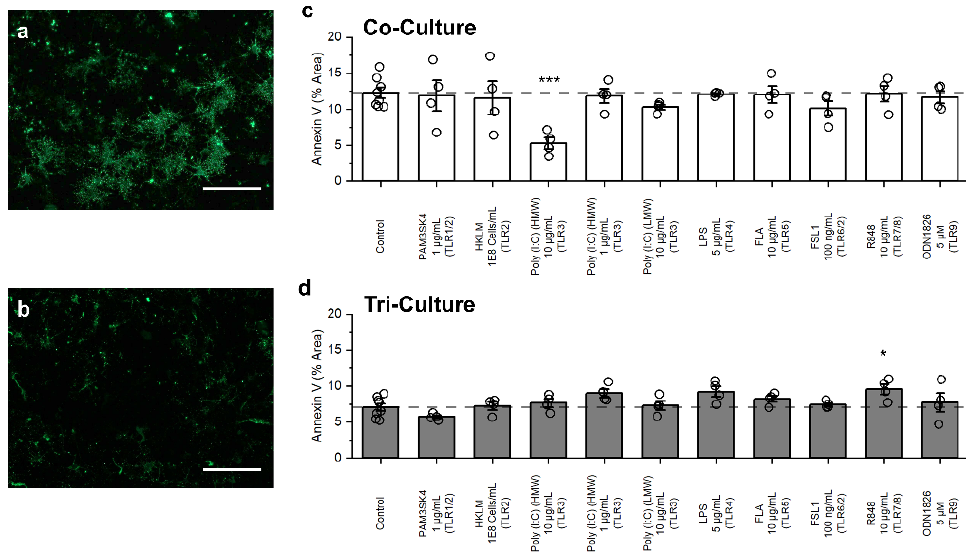
Figure 3. Influence of TLR agonist treatment on Annexin V staining. Representative fluorescence images of the ( a ) co-culture and ( b ) tri-culture at DIV 9. Quantification of the Annexin V staining in the ( c ) co-cultures and ( d ) tri-cultures following 48 h exposure to TLR agonists. Data presented as mean ± SEM (n = 4 wells from two independent dissections) with individual data points plotted, * p < 0.05, *** p < 0.001 (as determined by a one-way ANOVA followed by Dunnett’s test vs. vehicle control). Scale bar = 100 µm.